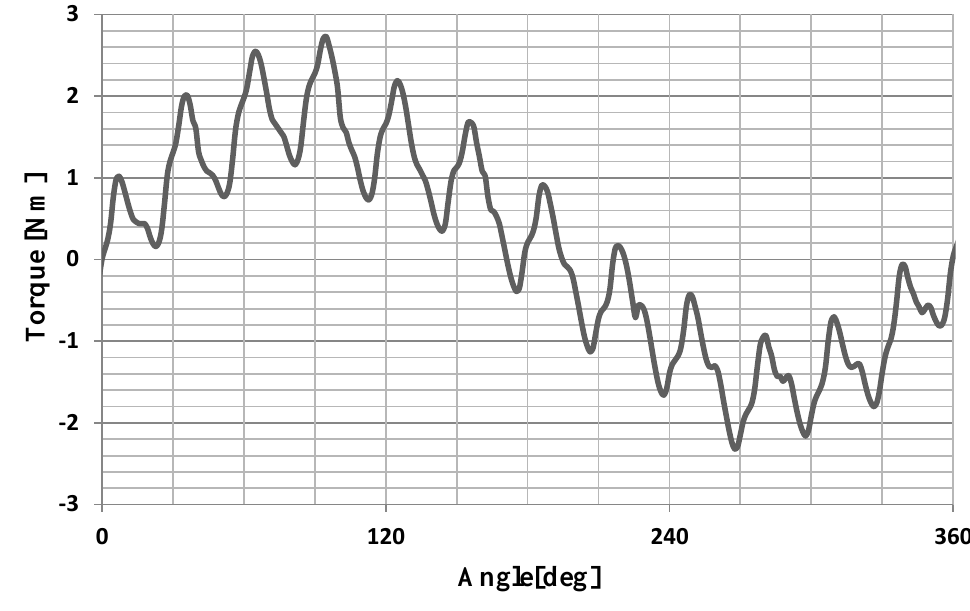
Figure 15. The static torque characteristic of the motor for a current of